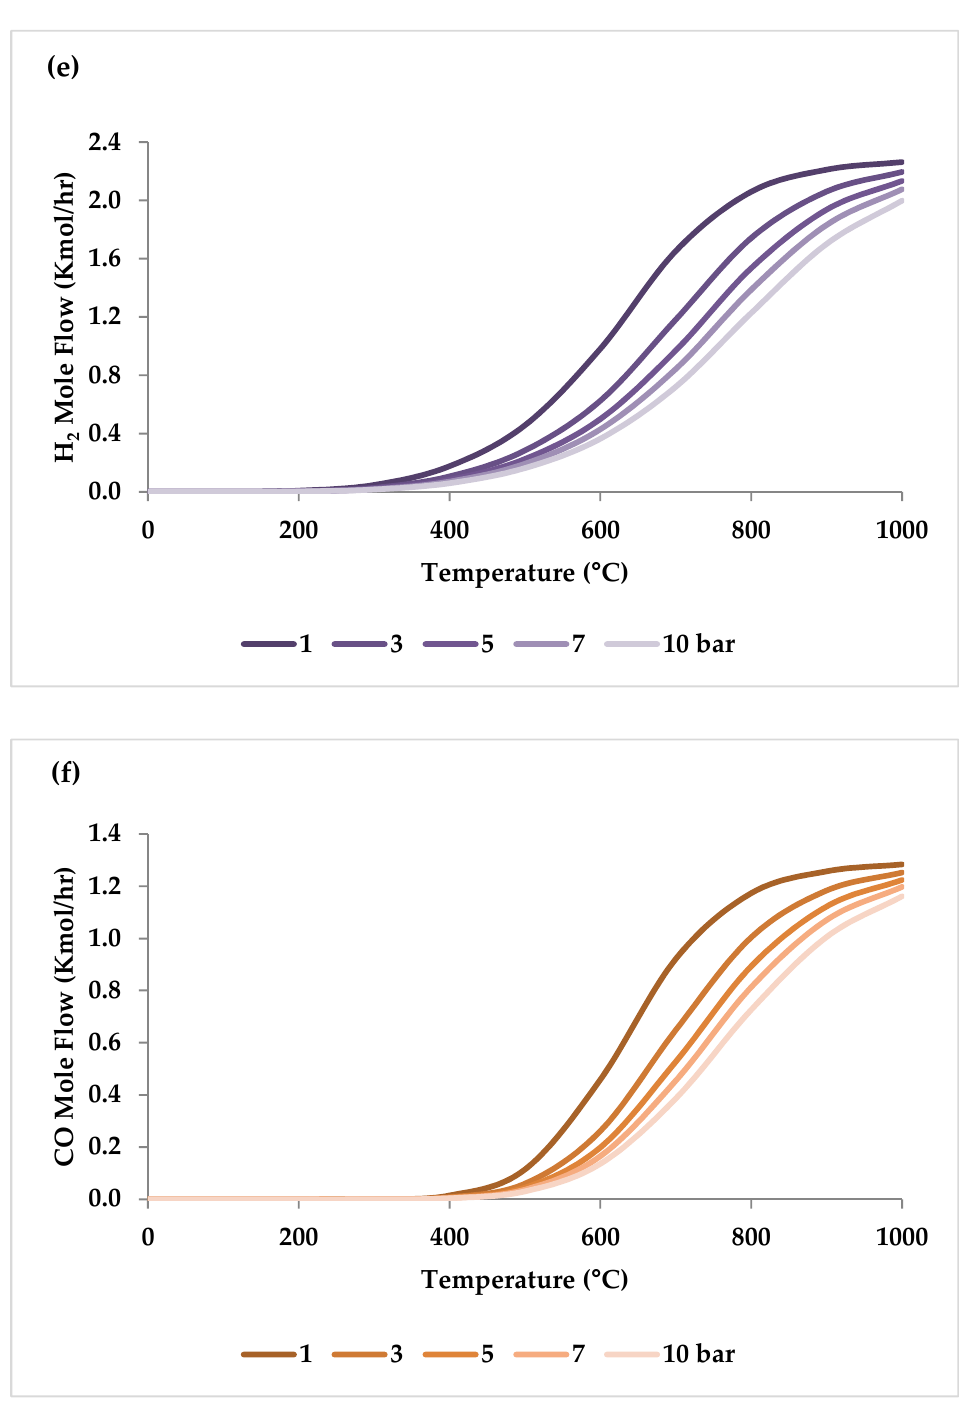
Figure 7. Thermodynamic equilibrium concentrations of ( a – d ) feed gases and ( e – f ) product gases under different pressures (bar) versus temperature, molar ratio: CH 4 :CO 2 :H 2 O:O 2 = 1:0.3:0.3:0.2.